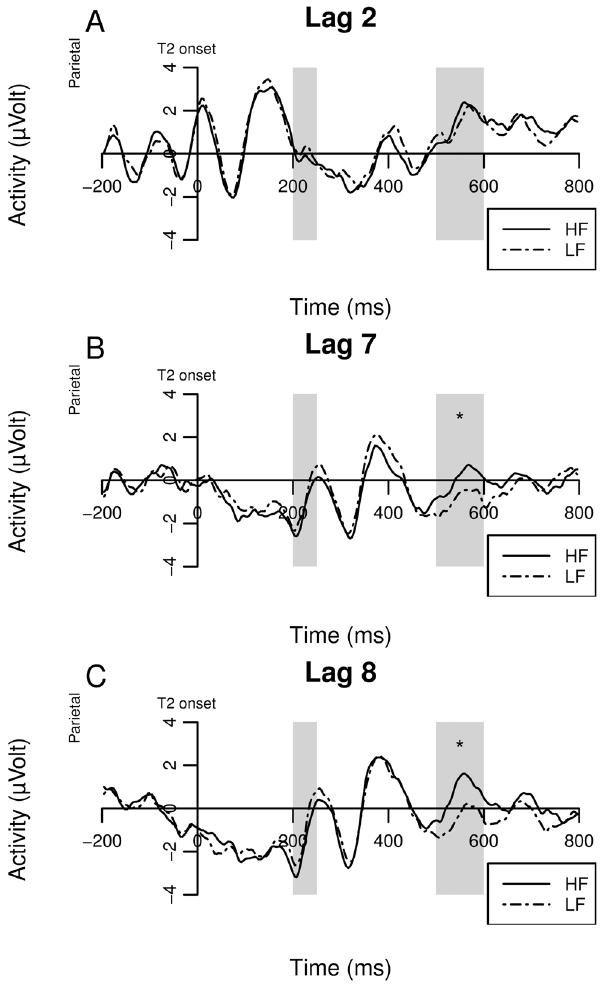
Figure 8. Grand averages for the ERPs of high-frequency and low-frequency words at lag 2 (A), 7 (B), and 8 (C). The ERPs are time-locked on target onset. Only correct trials were analyzed.